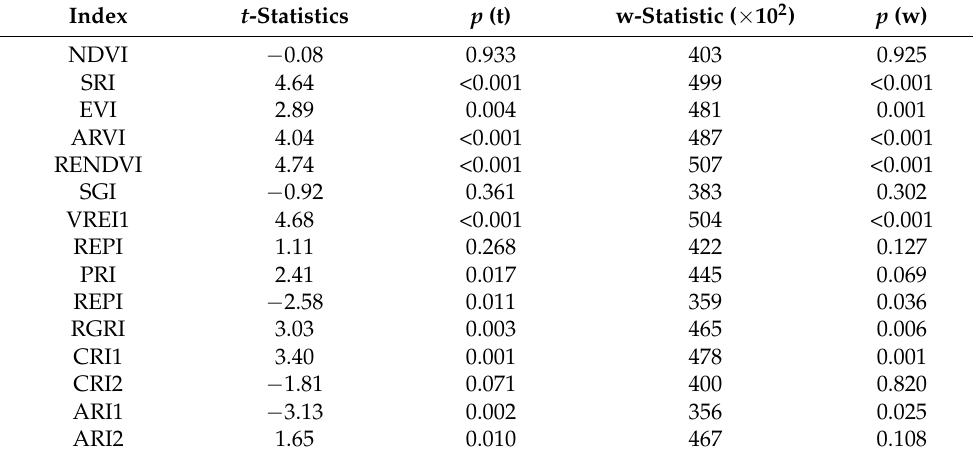
Table 6. Result of comparison of vegetation index values between infected and healthy trees